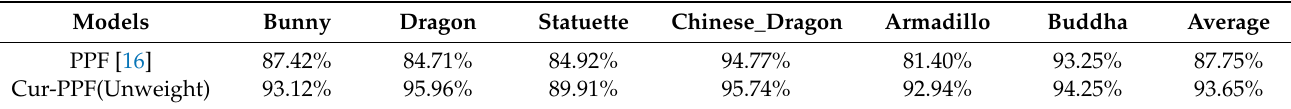
Table 1. The matching rate of PPF and Cur-PPF(Unweight) algorithms on public data set.